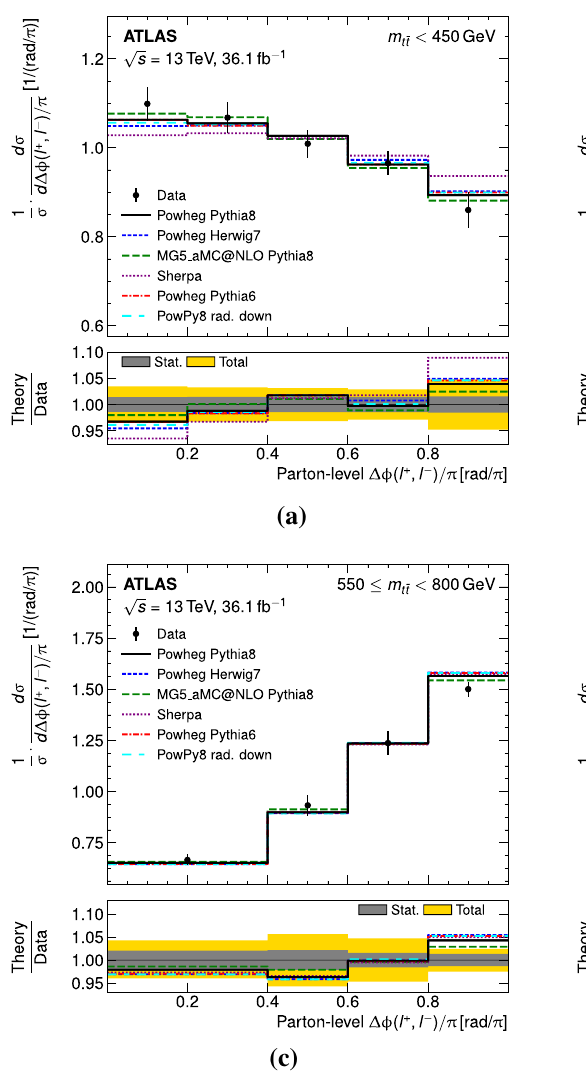
a m t ¯ t < 450 GeV, b 450 ≤ m t ¯ t < 550 GeV, c 550 ≤ m t ¯ t < 800 GeV, and d m t ¯ t ≥ 800 GeV. Each differential distribution is normalised to the integrated cross-section within the individual m t ¯ t